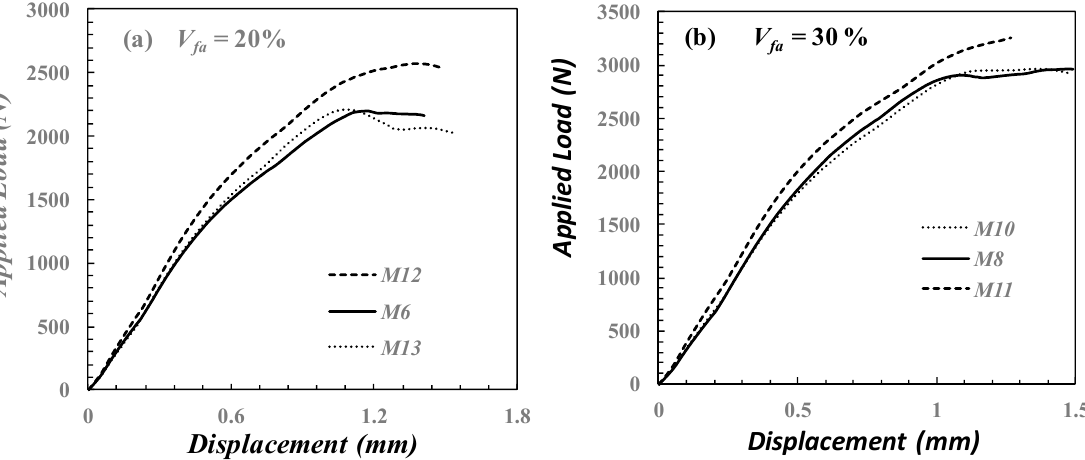
Figure 18. Numerical load–deflection curve of FGMs specimen with: ( a ) V fa of 20% and ( b ) V fa of 30%.